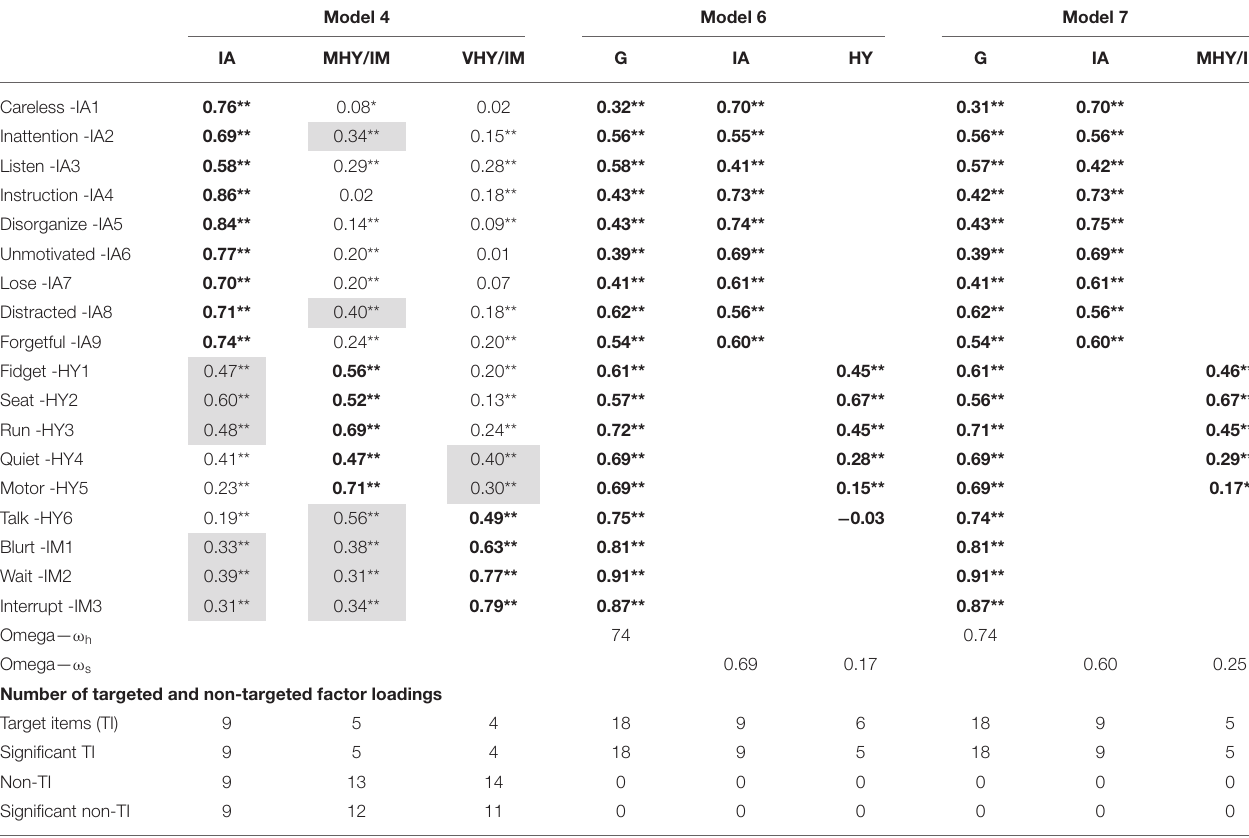
TABLE 2 | Factor loadings for 4, 6, and 7, based on parent